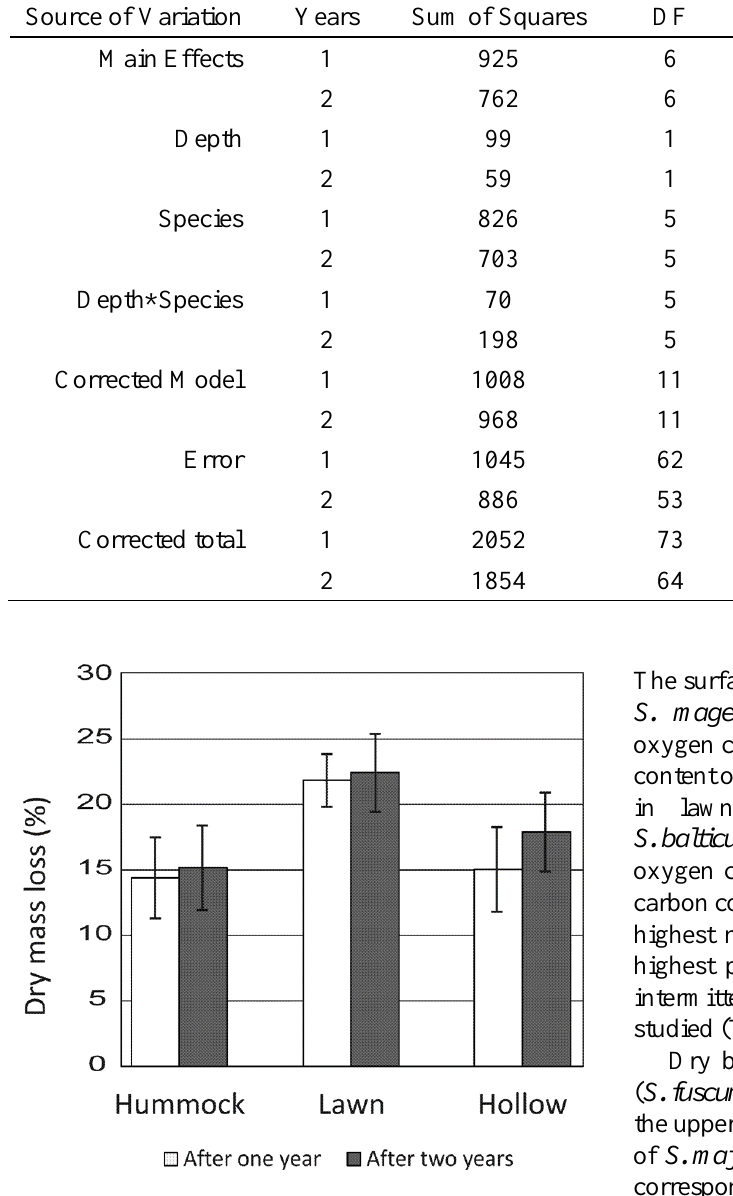
Figure 4. Average dry mass loss (%) and standard deviation in different microhabitats after one and two years, including all burial